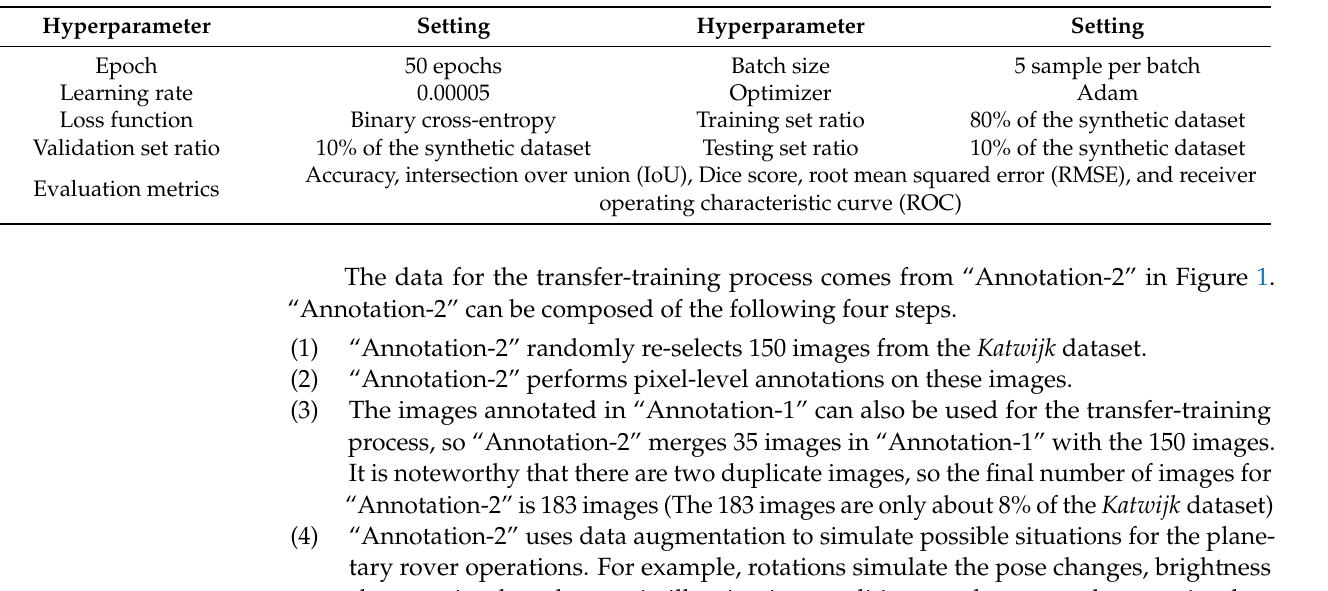
Table 4. The hyperparameters of the transfer-training